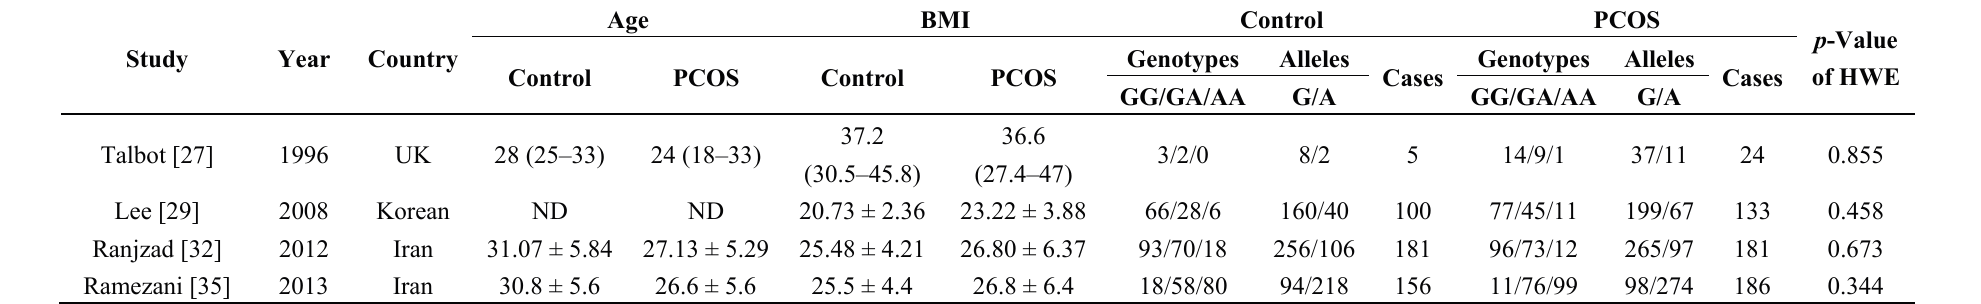
Table 4. Distribution of the INSR rs2059806 genotype and the allele frequencies for controls and PCOS cases.